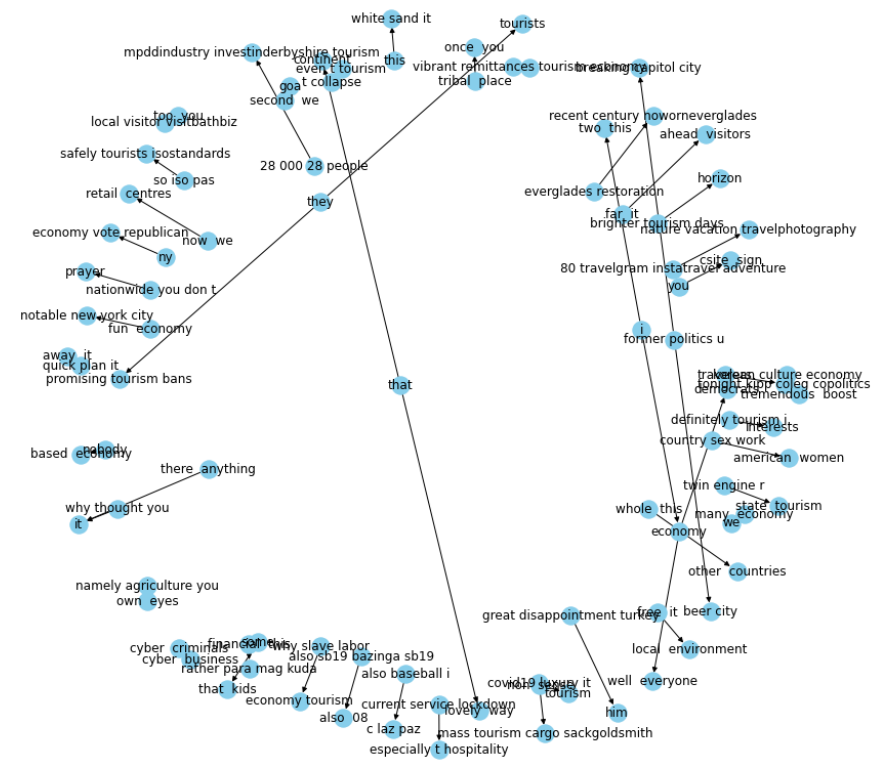
Figure 23. Knowledge Graph for Cluster 4.